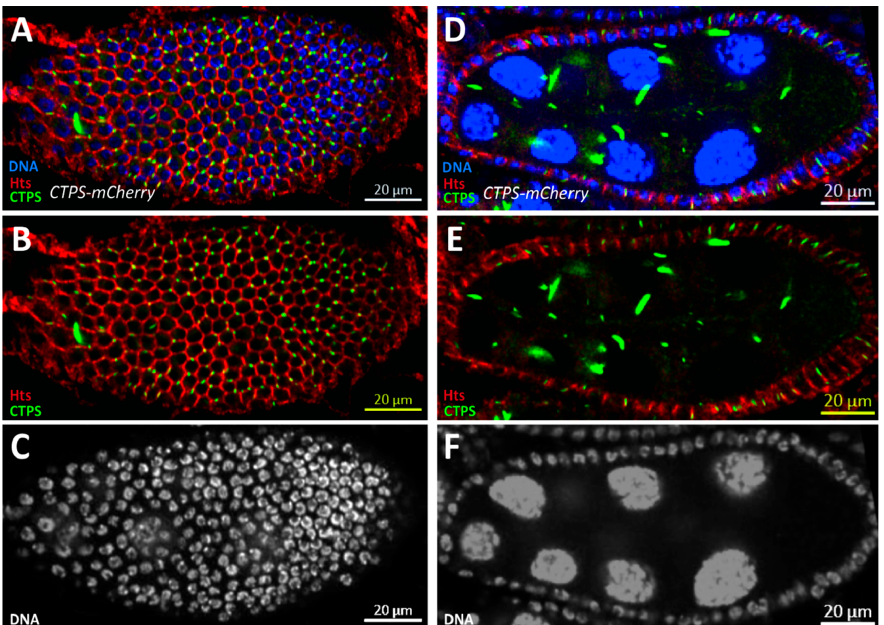
Figure 2. CTPS-mCh ovaries have same morphology as wild-type ovaries. ( A – C ) Surface view of a stage 8 CTPS-mCh egg chamber. The CTPS signal (green) shown is obtained using mCherry-tagged CTPS. Hts (red) staining marks cell membranes and Hoechst (blue) for DNA. ( A ) mCherry moiety doesn’t affect CTPS assembly. ( B ) Merged panel of Hts and CTPS to display the cytoophidia location. ( C ) Single panel of the nucleus. ( D ) Lateral view of a stage 8 CTPS-mCh egg chamber. ( E ) Merged panel of Hts and CTPS to show the monolayer structure of follicle epithelia as well as cytoophidia distribution. ( F ) Single panel of nucleus to stress the single-layer follicle epithelia. When constructing the point-mutated Drosophila strain, we added a mCherry tag at